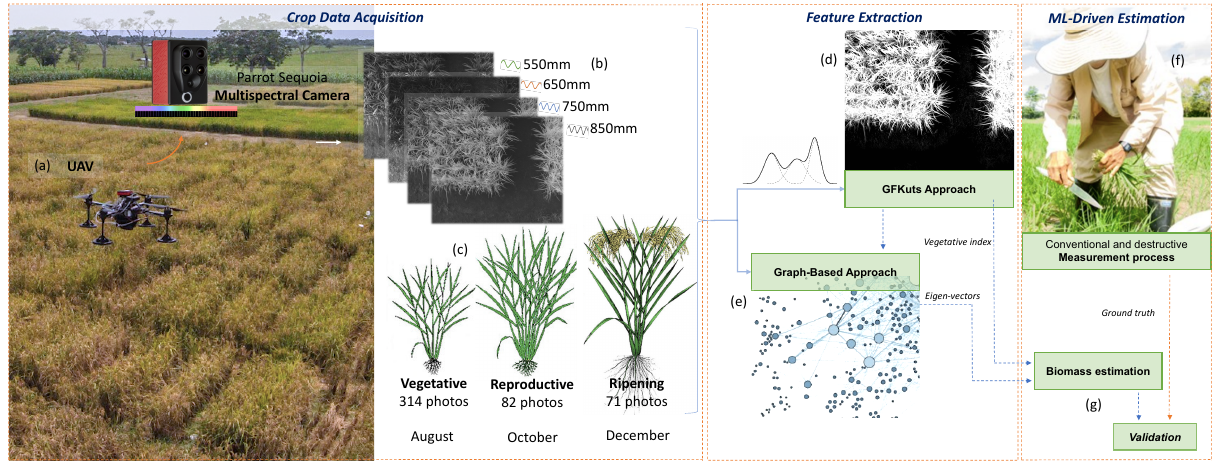
Figure 1. ( a ) UAV-driven remote sensing of above-ground biomass in rice crops. ( b ) Multispectral imagery. ( c ) Dataset amount & crop stages ( d ) First methodology—GFKuts. ( e ) Second methodology—Graph based. ( f ) Destructive biomass sampling. ( g ) Validation and correlation stage.